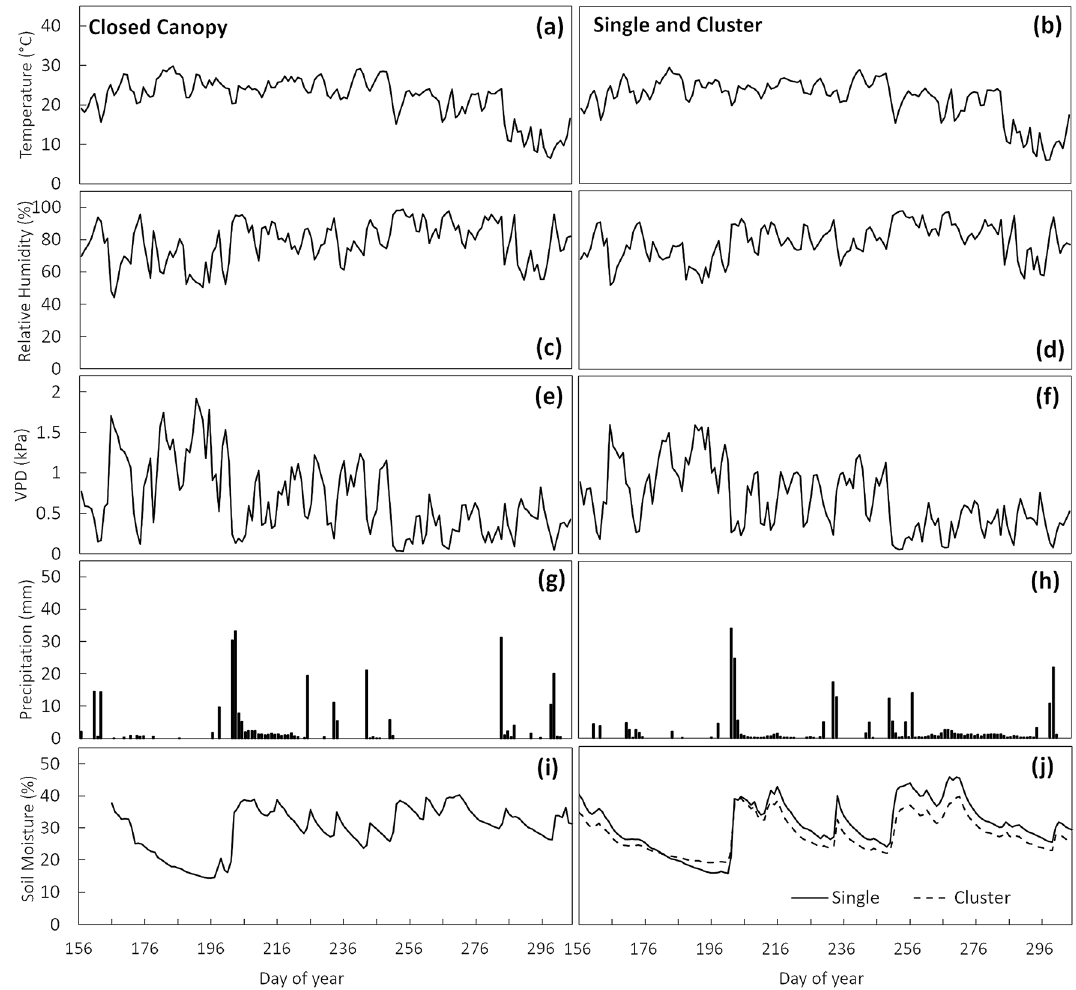
Figure 1. Microclimate in Baltimore, MD and Gaithersburg, MD from June to December of 2018. Mean daily air temperature for closed canopy site ( a ) and single and cluster sites ( b ); mean daily relative humidity for closed canopy site ( c ) and single and cluster sites ( d ); mean daily vapor-pressure deficit (VPD) for closed canopy site ( e ) and single and cluster sites ( f ); daily total precipitation for closed canopy site ( g ) and single and cluster sites ( h ); mean daily soil moisture in the closed canopy ( i ), single and cluster sites ( j ). Due to the later date of soil moisture sensors installation, there was a gap in the data for the closed canopy site.